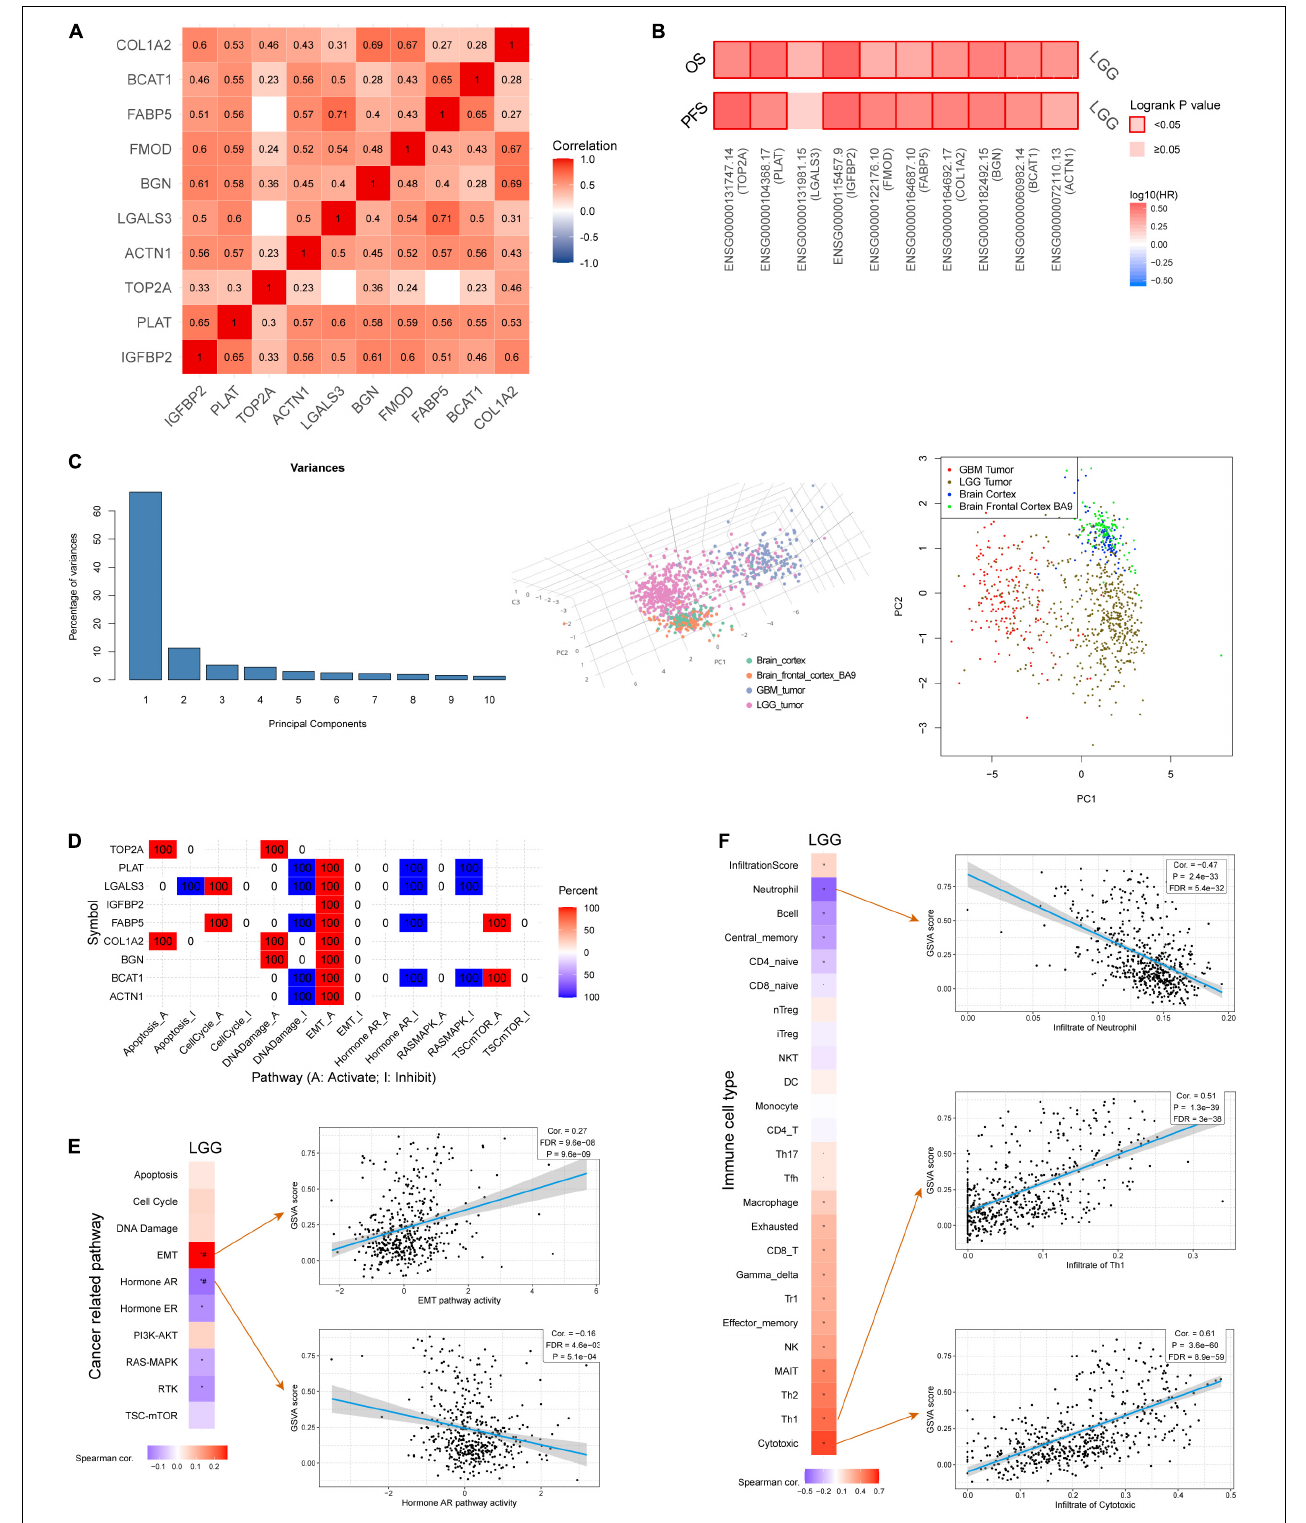
FIGURE 6 | Comprehensive analysis of model genes in the IIRS. (A) Spearman correlations among the model genes. (B) Cox analyses exhibiting the relationships between the expressions of model genes and OS and PFS. (C) PCA analysis. (D) Involvement of individual model genes in cancer related pathways. (E) Correlation between GSVA score and cancer related pathways. (F) Correlation between GSVA score and immune cell types.